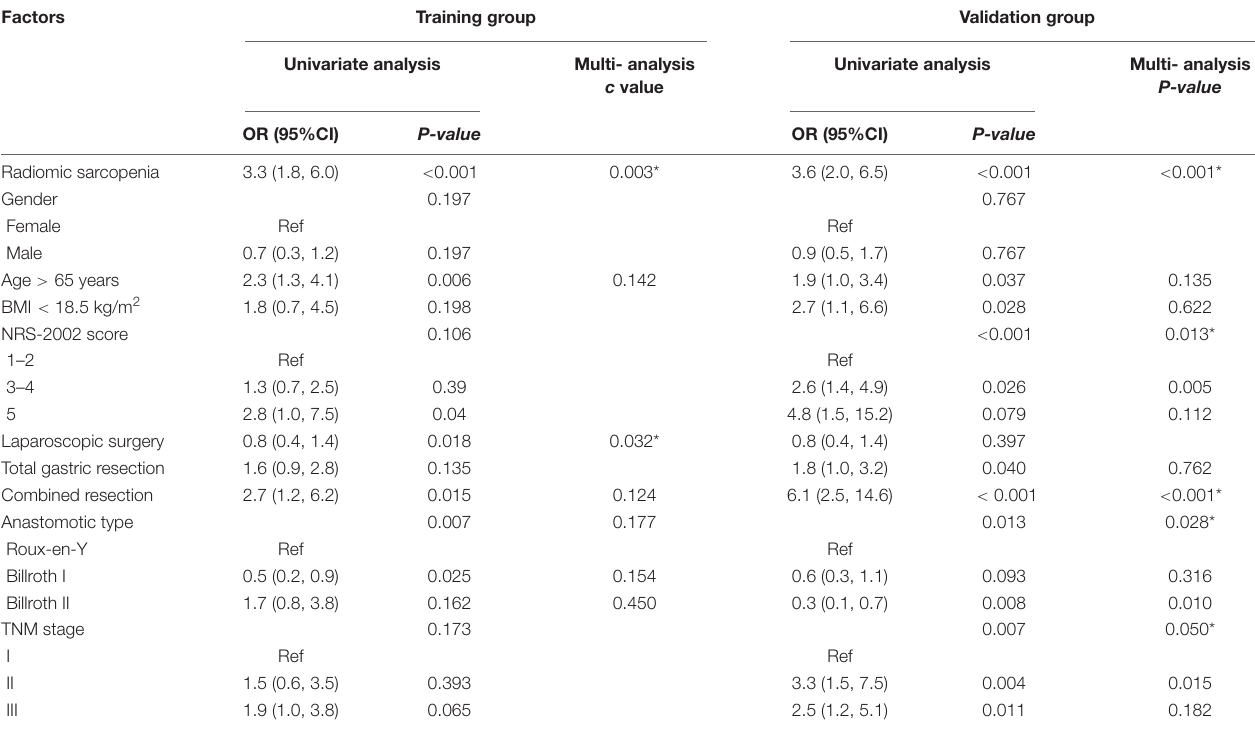
TABLE 2 | Univariate and multivariate analysis of postoperative